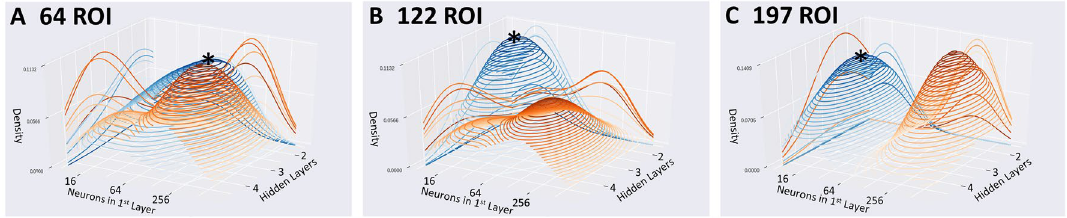
Figure 4. Kernel Density Estimates from the DFNN hyperparameter search reveals the density of highest performing configurations (top 20%) shown in blue, and low performing configurations (lowest 20%) in orange. Densities of DFNN configurations using the coarse BASC atlas ( A ), medium atlas ( B ), and fine atlas ( C ). Peaks of blue surfaces are marked with * 63,64 .